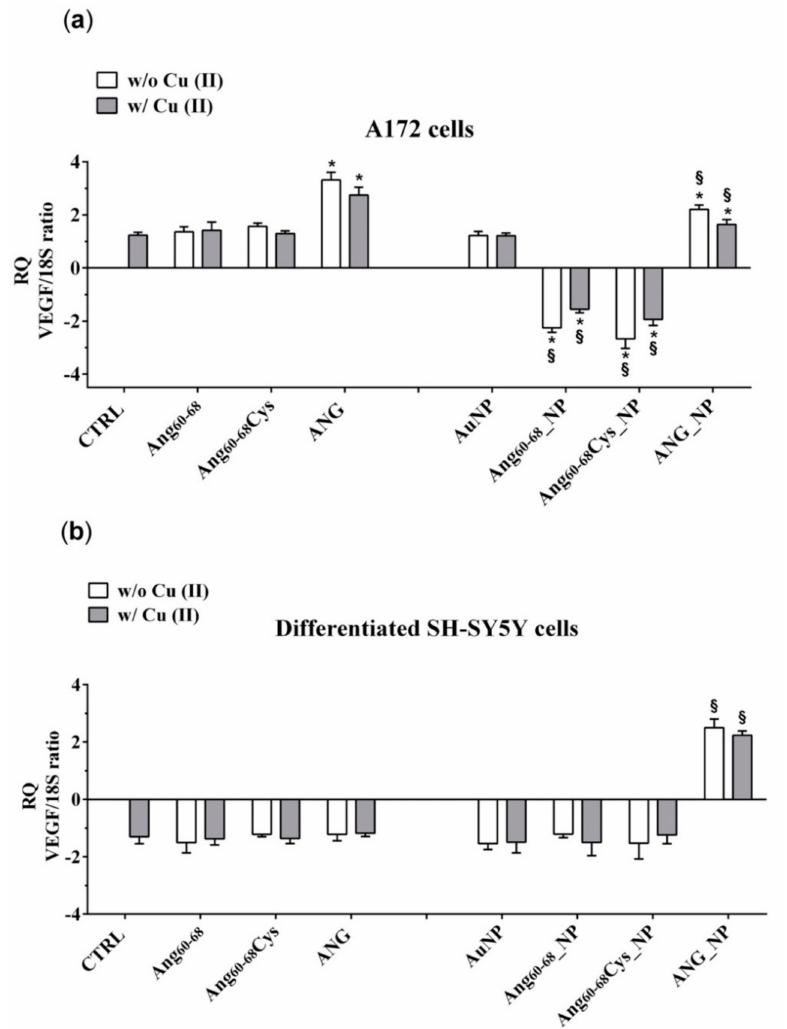
Figure 7. Vascular endothelial growth factor (VEGF) mRNA levels determination by qPCR in A172 ( a ) and di ff erentiated d-SH-SY5Y cells ( b ). Cells were grown in basal culture medium (control: CTRL) and in culture medium supplemented with: Ang 60–68 (30 µ M), Ang 60–68 Cys (30 µ M); ANG (100 nM), AuNP (9.4 nM = 1.4 × 10 8 NP / mL), Ang 60–68 _NP (1.4 nM = 4.0 × 10 6 NP / mL, [Ang 60–68 ] = 2.8 × 10 − 12 M), Ang 60–68 Cys_NP (1.4 nM = 4.0 × 10 6 NP / mL, [Ang 60–68 Cys] = 2.6 × 10 − 12 M), ANG_NP (1.2 nM = 3.4 × 10 6 NP / mL, [ANG] = 0.2 × 10 − 12 M). All conditions were evaluated in presence or absence of metal ions (copper sulphate: Cu(II), 20 µ M). Relative quantification is referred to untreated cells (CTRL). Data normalized with respect to the expression level of S18 mRNA. The bars represent means ± standard deviation (SD) of three independent experiments performed in triplicate. Statistically significant di ff erences, determined by one-way analysis of variance (ANOVA) are indicated: * p ≤ 0.05 versus control; § p ≤ 0.05 versus the respective treatment with free peptides /